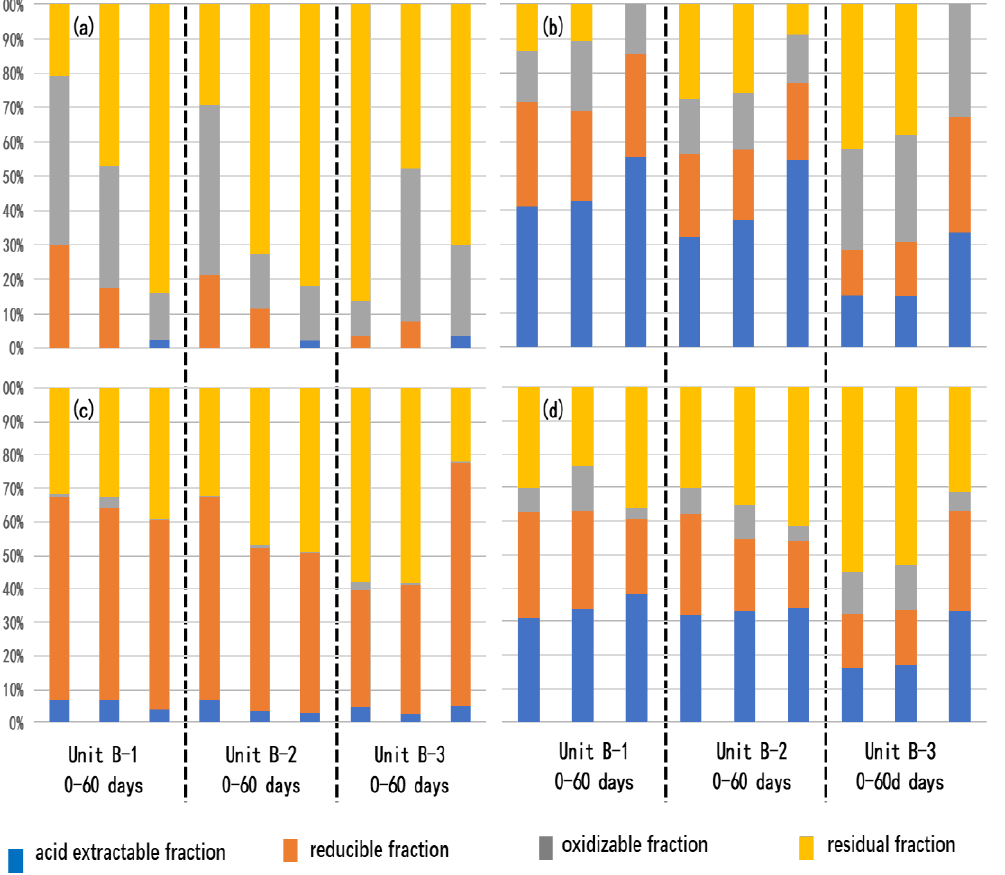
Figure 7. Effect of coupled stabilization after 30 and 60 days: ( a ) fraction distribution of As after 0, 30, and 60 days; ( b ) fraction distribution of Cu after 0, 30, and 60 days; ( c ) fraction distribution of Pb after 0, 30, and 60 days; ( d ) fraction distribution of Zn after 0, 30, and 60 days.